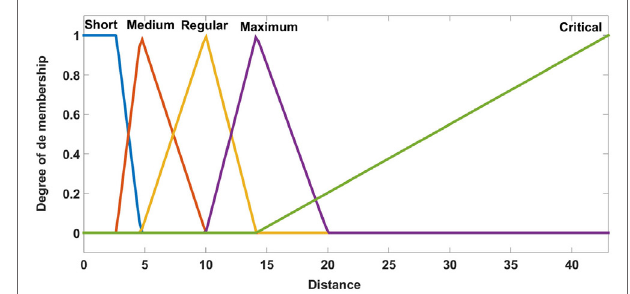
FigUre 4 | Membership functions of distance.